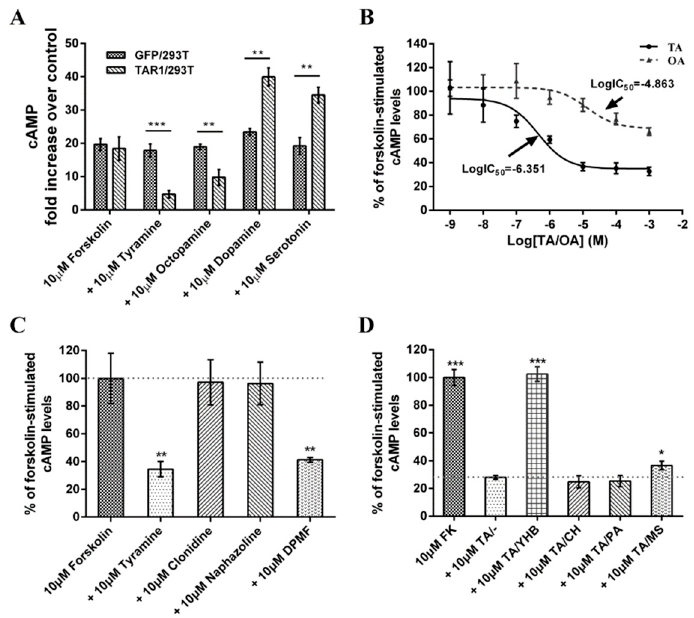
Figure 5. Regulation of (cAMP)i in HEK-293T cells stably expressing the PxTAR1 receptor (TAR1/293T) compared to GFP/293T cells (negative control). ( A ) Regulation of forskolin and biogenic amines on (cAMP)i. ( B ) Dose–response analysis of TAR1/293T cells to TA and OA and attenuation of forskolin-stimulated intracellular cAMP levels. ( C ) Regulation of putative agonists (clonidine, naphazoline, and DPMF) on forskolin-stimulated cAMP levels in TAR1/293T cells. ( D ) Regulation of putative antagonists on TA attenuation of forskolin-stimulated intracellular cAMP levels. Abbreviations: TA/–, tyramine and no antagonist; TA/YHB, tyramine + yohimbine; TA/CH, tyramine + chlorpromazine; TA/PA, tyramine + phentolamine; TA/MS, tyramine + mianserin. Data are presented as means ± SE of three experiments ( n = 3). Statistically significant differences: *** p ≤ 0.001, ** p ≤ 0.01, * p ≤ 0.05.